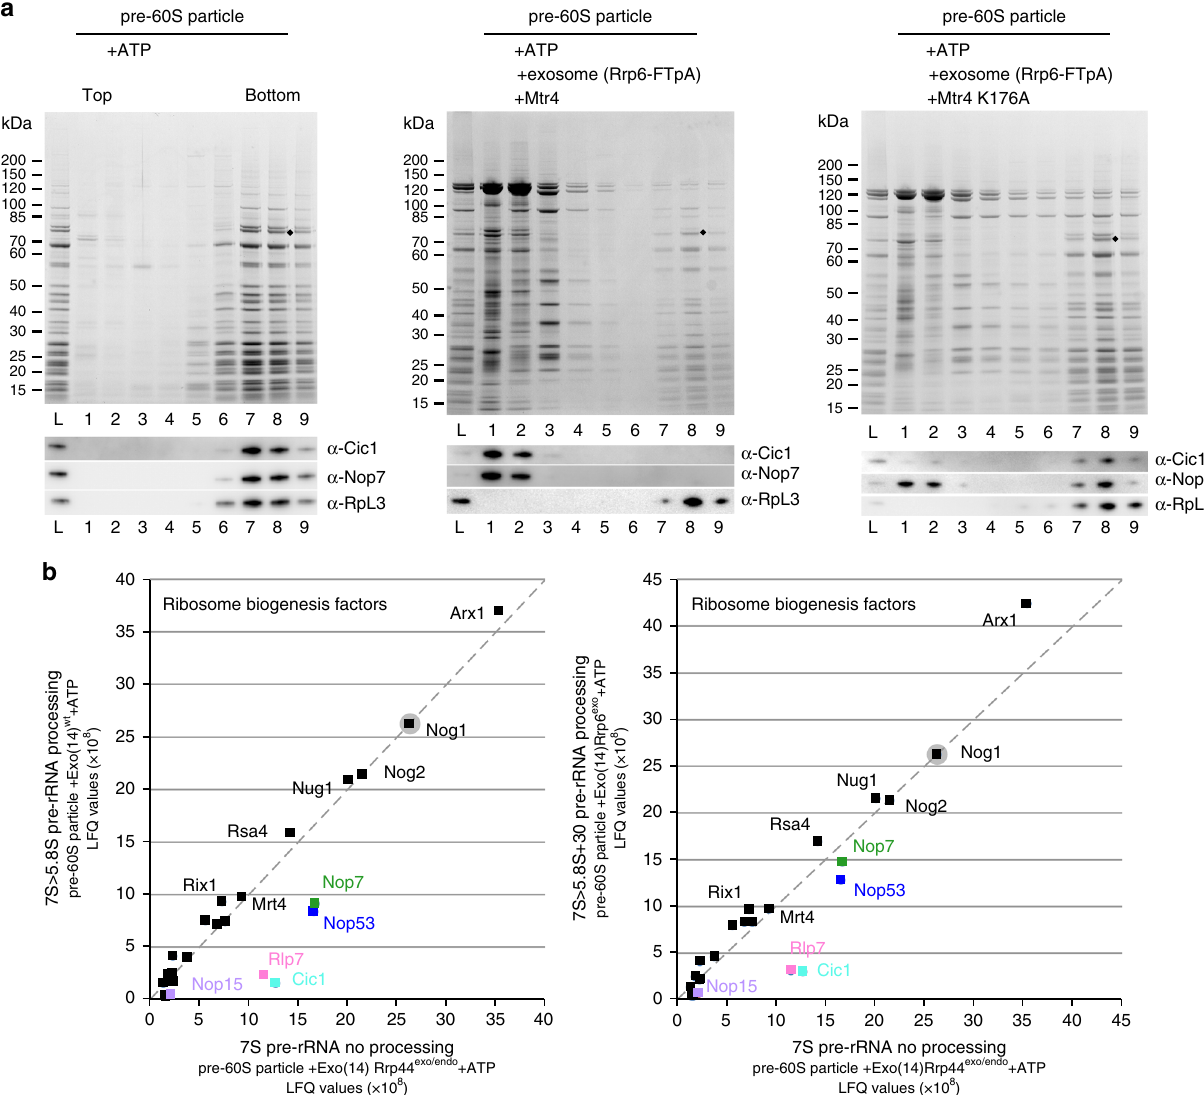
Fig. 3 Removal of ITS2-associated factors from the pre-60S particles upon in vitro 7S → 5.8S pre-rRNA processing. a Glycerol gradient centrifugation of pre- 60S particles (af fi nity-puri fi ed via TAPF-Nop53) after the in vitro processing reaction using endogenous yeast exosome (af fi nity-puri fi ed via Rrp6-FTpA) and recombinant wt Mtr4 or mutant Mtr4 (K176A) in the presence of ATP. As a control, the pre-60S particle was also incubated only with ATP (mock). After centrifugation, the linear glycerol gradient was fractionated into fractions 1 – 9, which were TCA-precipitated and analysed by SDS-PAGE and Coomassie staining (upper panel) or western blotting using the indicated antibodies (lower panel), with Rpl3 serving to identify the particle fractions. The bottom fractions (7 – 9) contained the pre-60S particles, whereas the top fractions (1 – 2) contained the released factors such as Cic1 and Nop7. Ribosome assembly factor Nog1 not released during the in vitro reaction is indicated by a dot (fraction 8). b Semi-quantitative mass spectrometry of pre-60S particle glycerol gradient fraction 8 after 7S → 5.8S pre-rRNA processing by recombinant nuclear exosome (see Supplementary Fig. 3b). Label-free quanti fi cation (LFQ) values between the different experiments (7S → 5.8S pre-rRNA processing, 7S → 5.8S + 30 pre-rRNA processing, no 7S pre-rRNA processing) were normalised to Nog1. Afterwards, pairs of LFQ values of ribosome biogenesis factors obtained from different processing stages were compared by plotting them against each other. Left: '7S → 5.8S pre-rRNA processing' (pre-60S particle + Exo(14) wt + ATP) vs. 'no 7S pre-rRNA processing' (pre-60S particle + Exo(14)Rrp44 exo/endo + ATP). Right: '7S → 5.8S + 30 pre-rRNA processing' (pre-60S particle + Exo(14)Rrp6 exo + ATP) vs. 'no 7S pre-rRNA processing' (pre- 60S particle + Exo(14)Rrp44 exo/endo + ATP). Labelled in colour are ribosome assembly factors associated with ITS2, which signi fi cantly dropped below the dashed reference line ( x = y ), indicating release from the 60S particles. In contrast, most of the other pre-60S factors remained close the reference line, indicating no signi fi cant release from the pre-60S particles. All experiments were performed twice with similar outcomes (see Supplementary Table